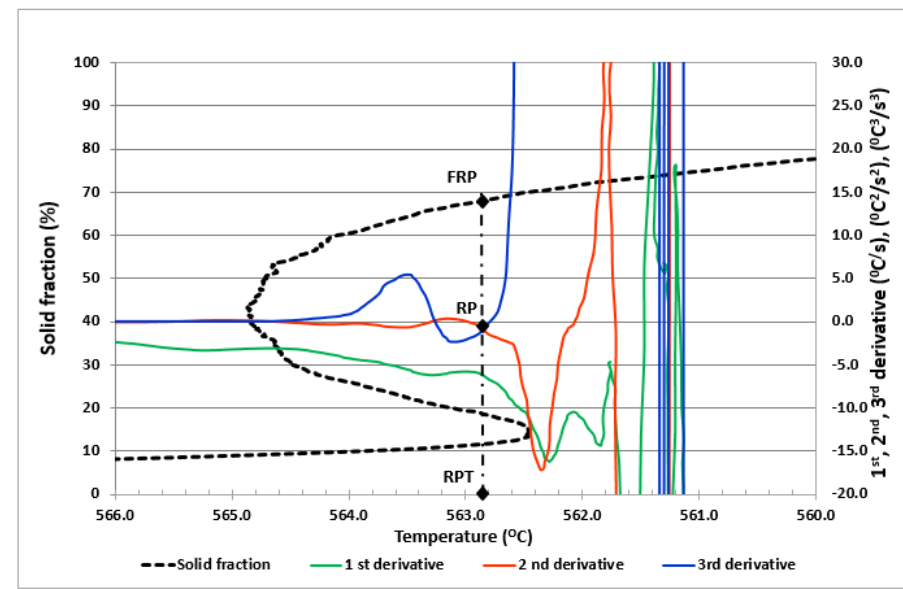
Figure 1. Determination of RPT and FRP at the crossing point of the second and third derivative of the curve dT/dt vs. T.